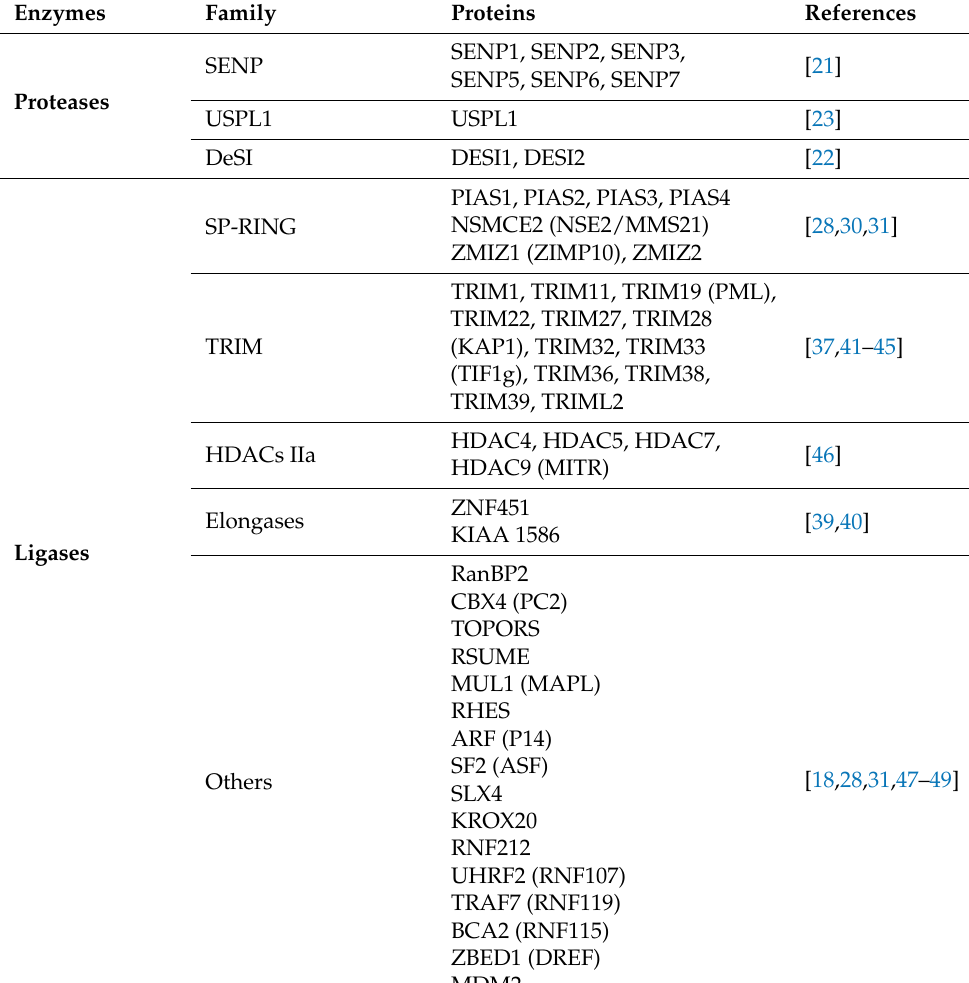
Table 1. SUMO proteases and